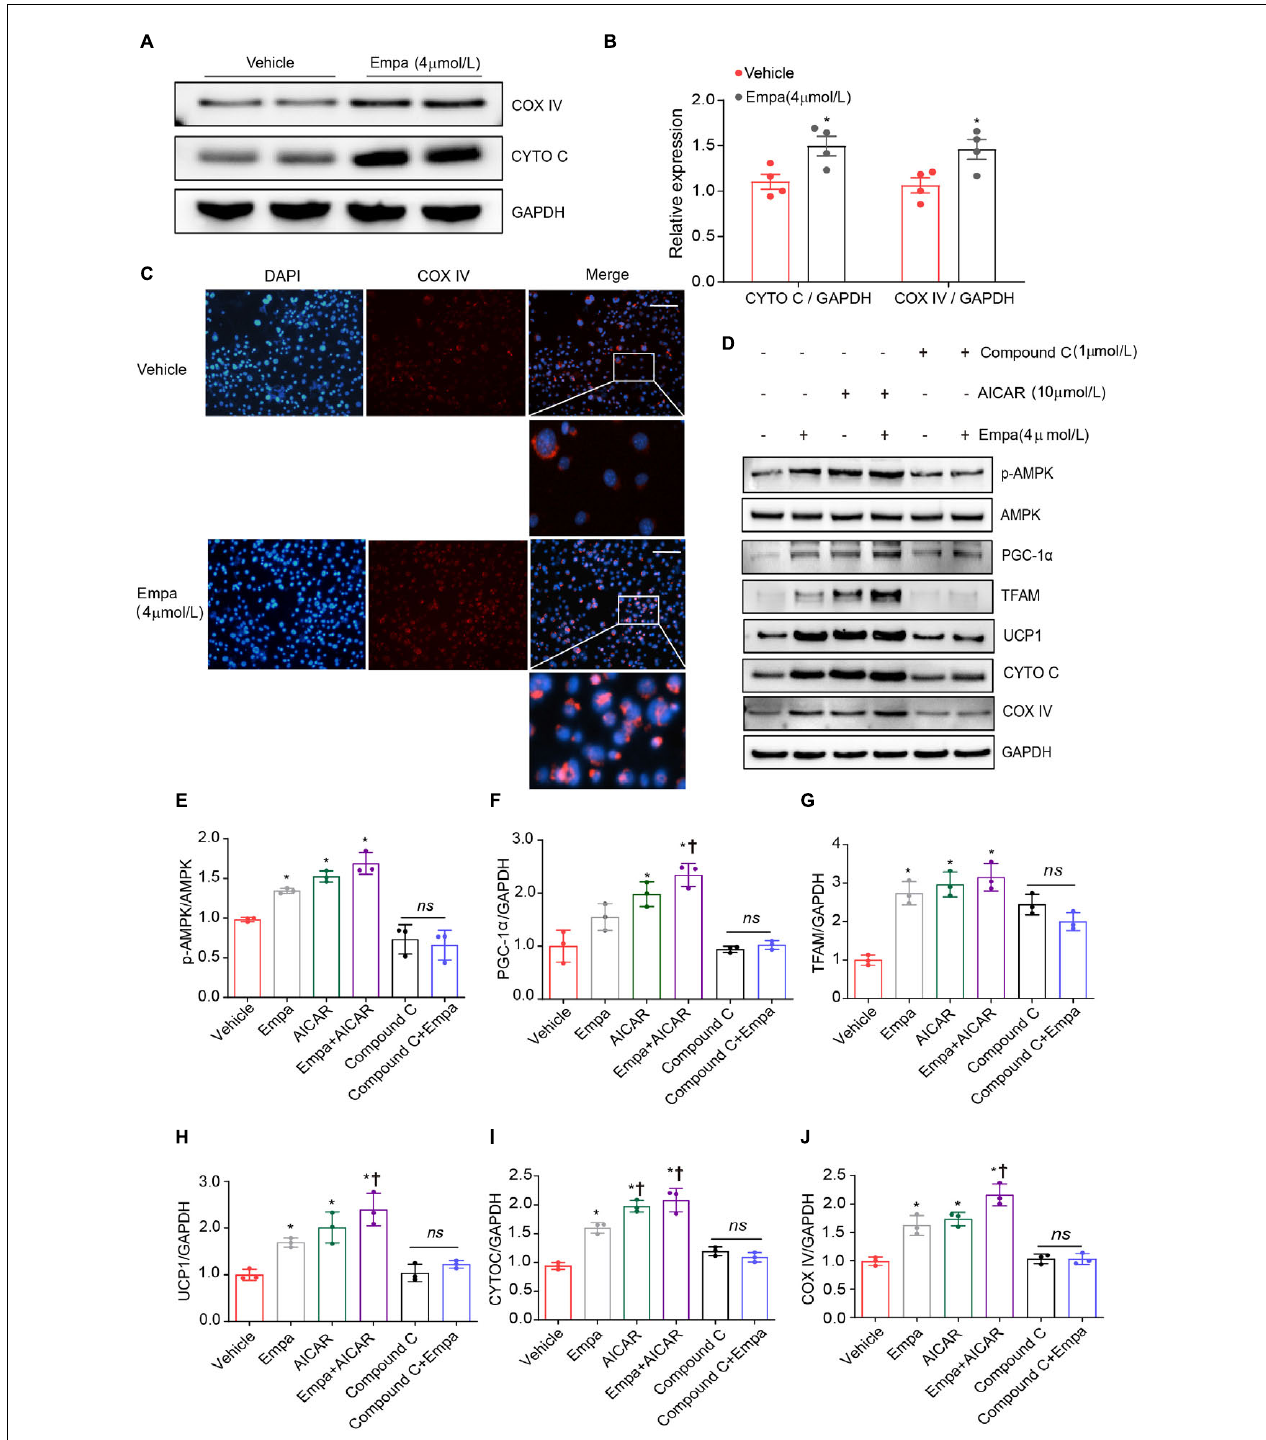
FIGURE 6 | Upregulation of UCP1 and mitochondrial biogenesis by empagliflozin are dependent on AMPK activity. (A,B) Western blot and quantitation of COX IV and CYTO C with GAPDH as a loading control. (C) Immunostaining was used for analysis of the abundance of COX IV in empagliflozin-treated 3T3-L1 cells. COX IV was labeled red, and the nuclei of cells were stained blue. Representative images are shown. Image magnification is 200 × . (D–J) Mature 3T3-L1 adipocytes were treated with (Empa) or without (Vehicle) empagliflozin (4 µ mol/L), with or without AICAR (10 µ mol/L), and with or without Compound C (1 µ mol/L). Western blot and quantitation of p-AMPK, AMPK, PGC-1 α , TFAM, UCP1, CYTO C, and COX IV, with GAPDH used as a loading control. Data are presented as mean ± SEM. * P < 0.05 vs. Vehicle; † P < 0.05 vs. Empa.